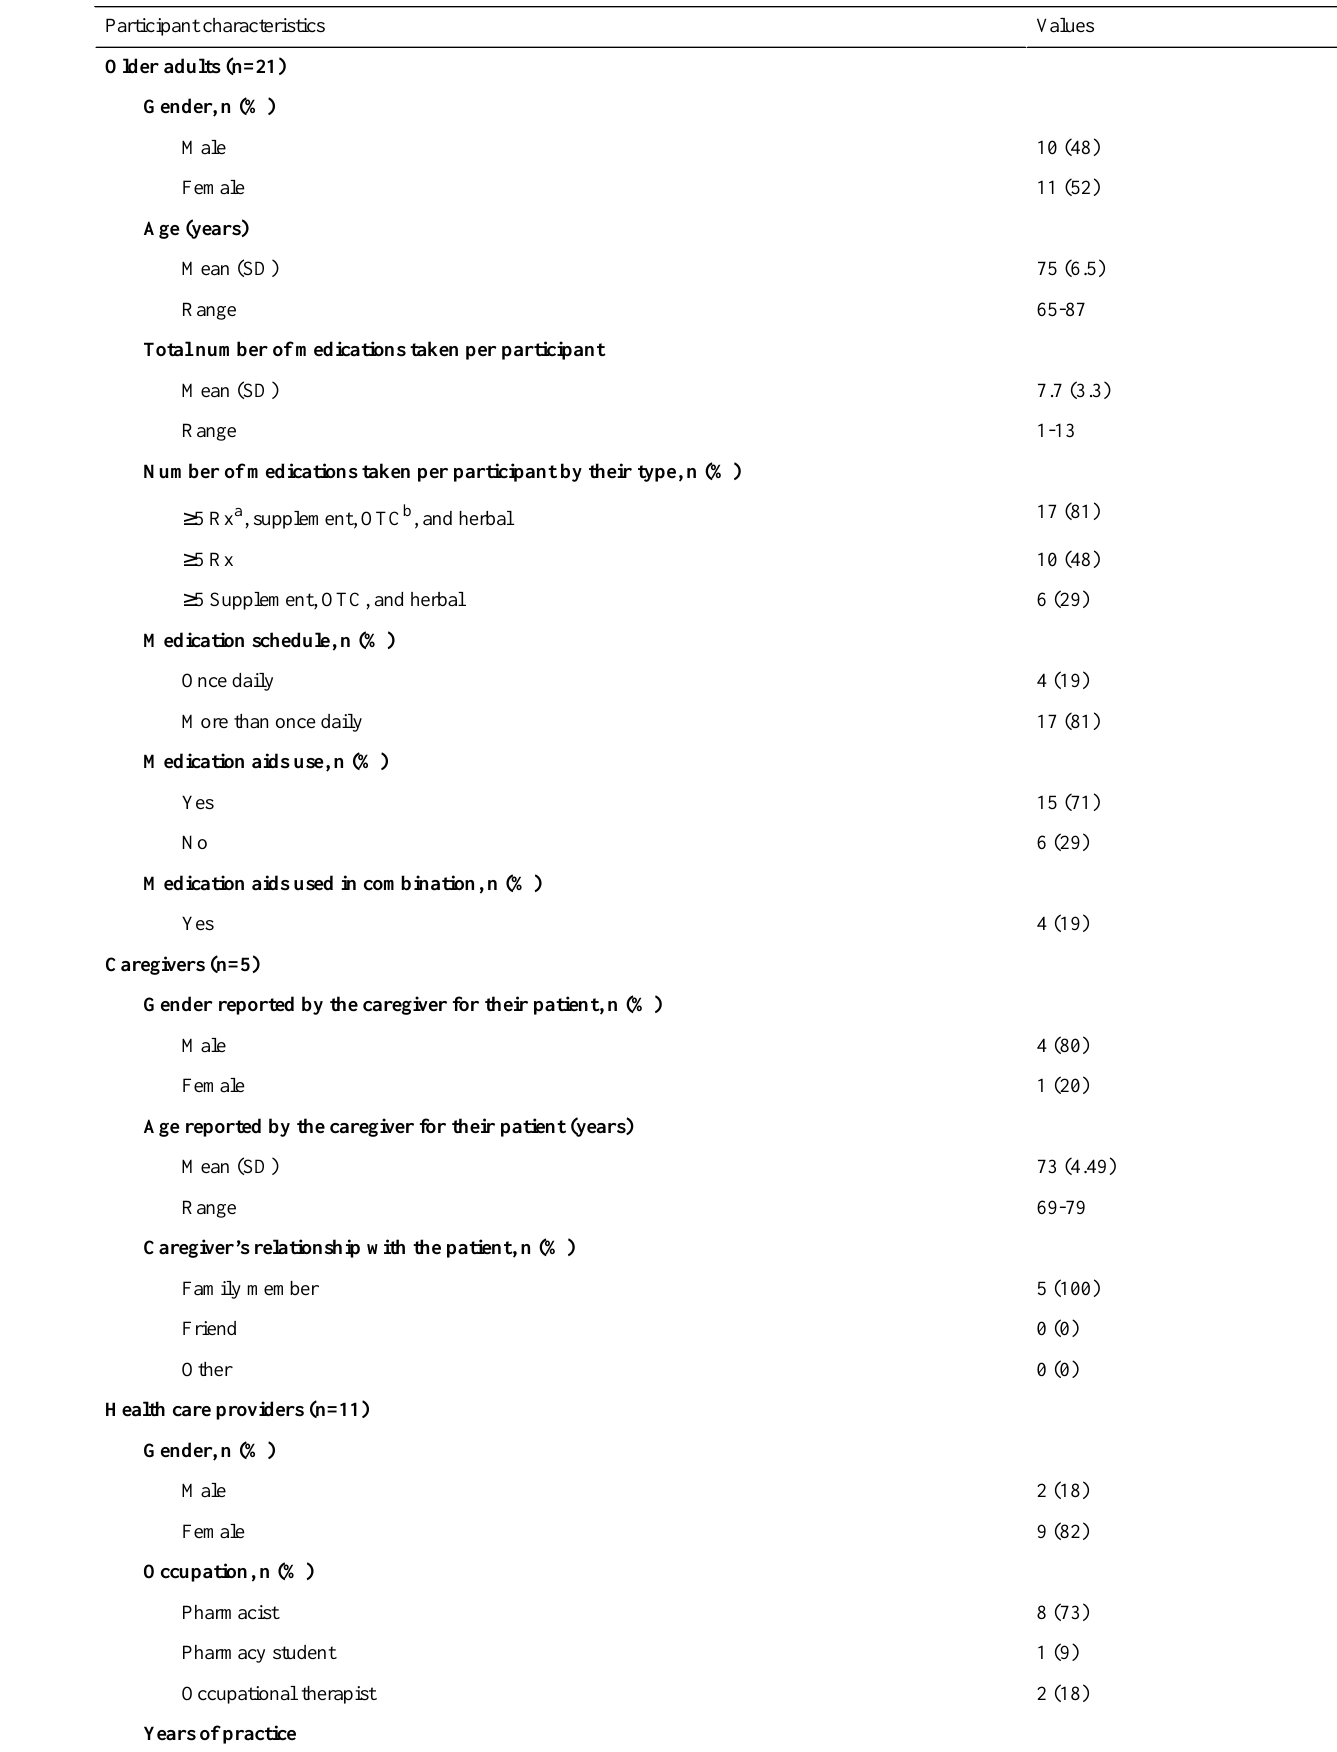
Table 2. Study participant characteristics